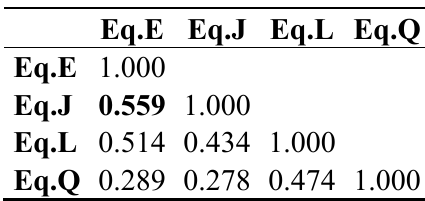
Table 5. Cross-correlation matrix among the residual values of Equations E , J , L , and Q